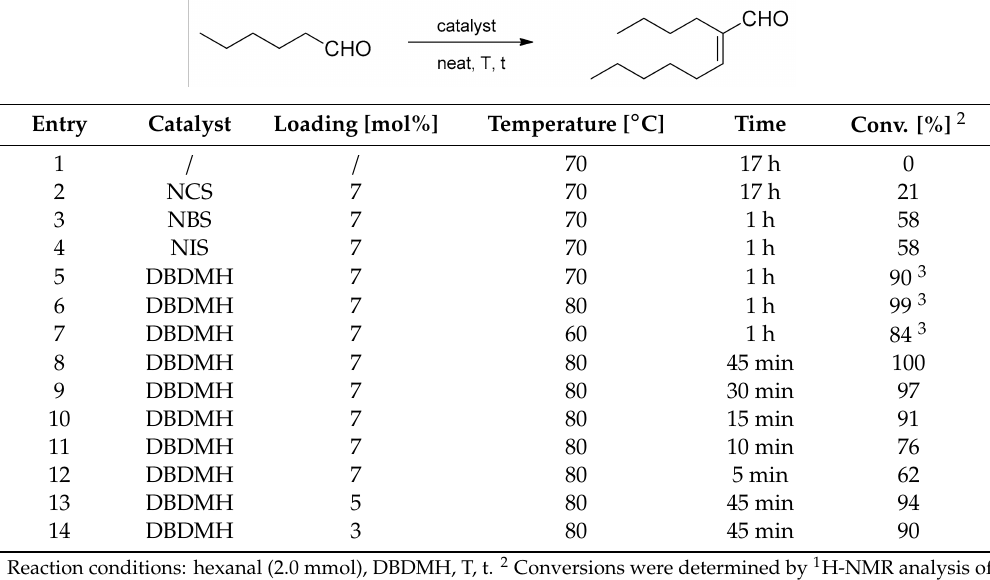
Table 8. Catalyst, catalyst loading, temperature, and time optimization for aldol condensation of hexanal 1 .